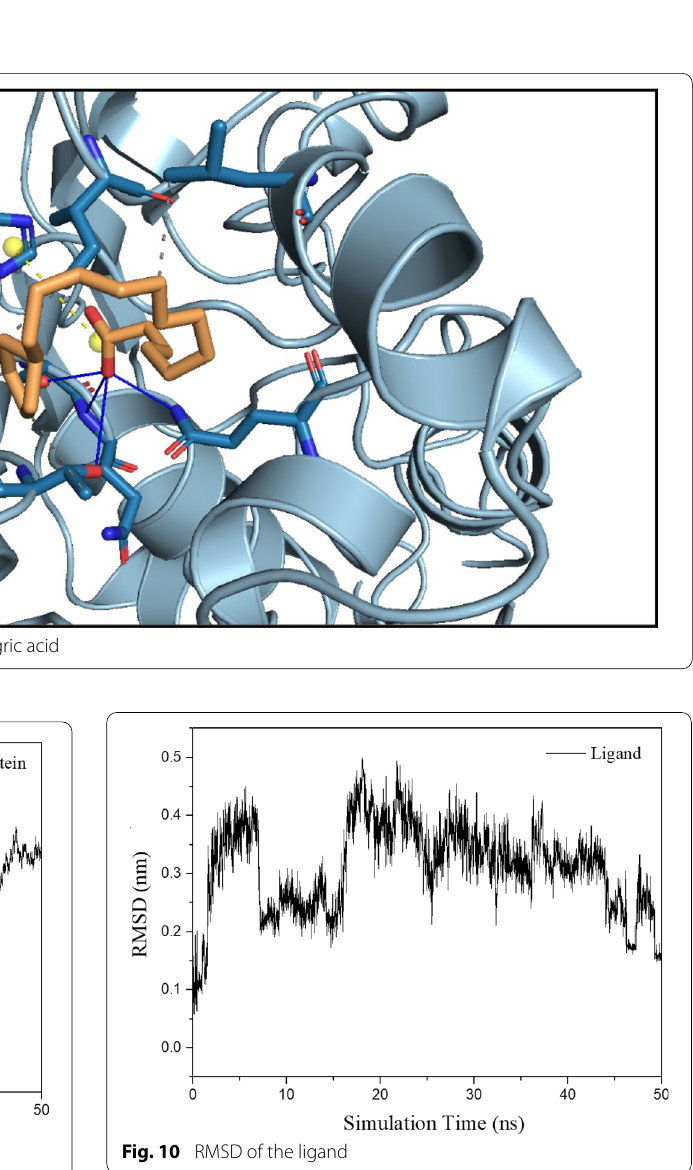
Fig. 9 RMSD of the receptor protein